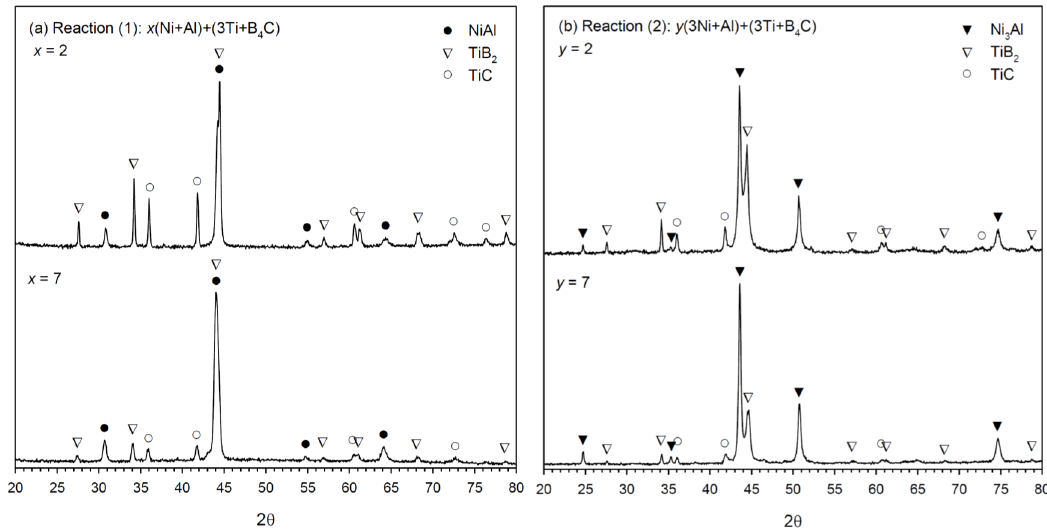
Figure 5. XRD patterns of self-propagating high-temperature synthesis (SHS)-derived products from ( a ) Reaction (1) with x = 2 and 7 and ( b ) Reaction (2) with y = 2 and 7.